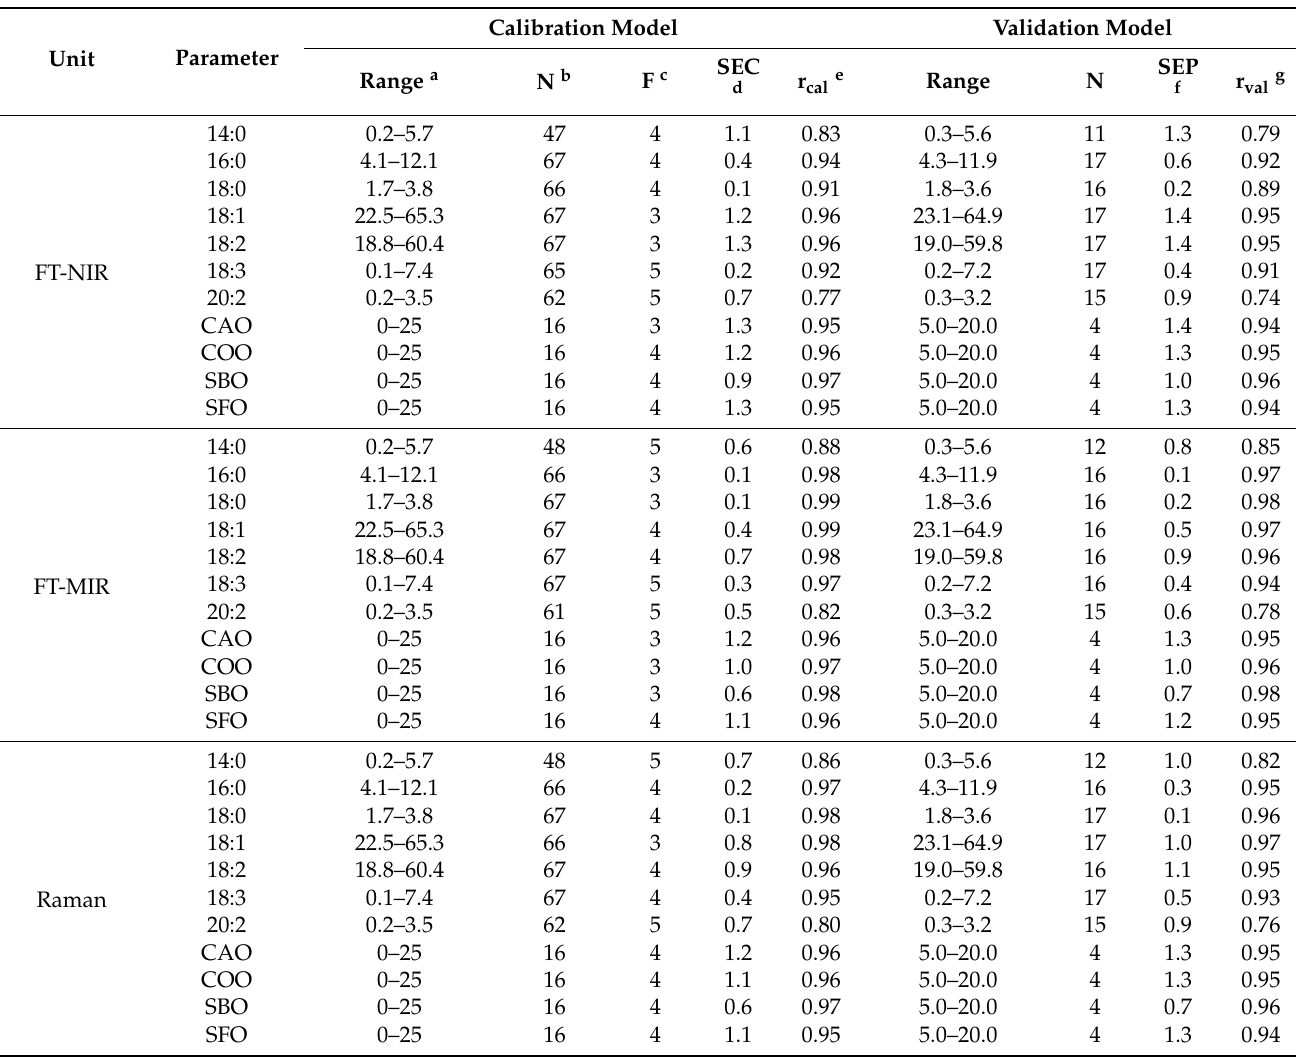
Table 3. Statistical performance of the prediction models developed using FT-NIR, FT-MIR, and Raman spectrometers for predicting fatty acid and adulteration levels of black cumin